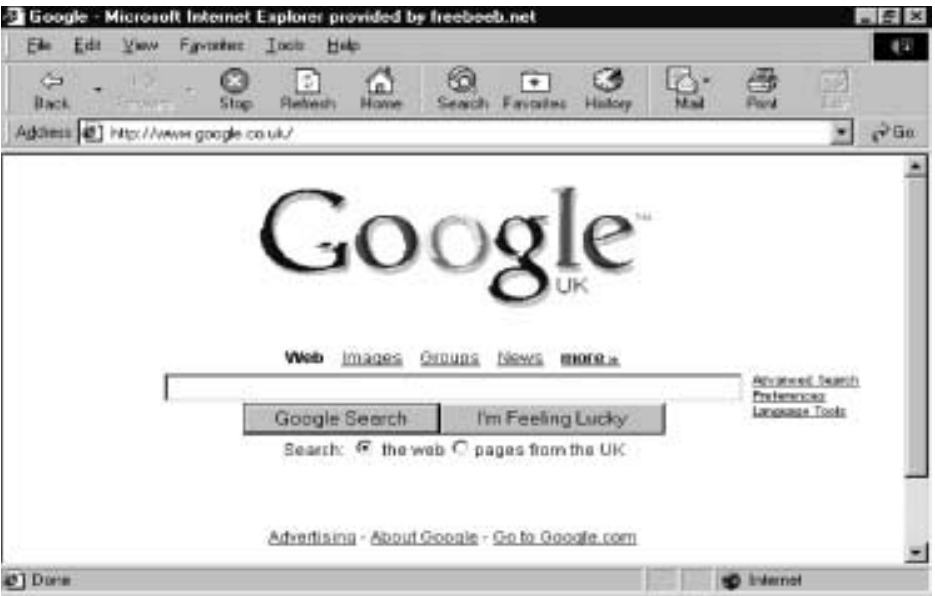
Figure 2. The Google basic search interface—simple and elegant